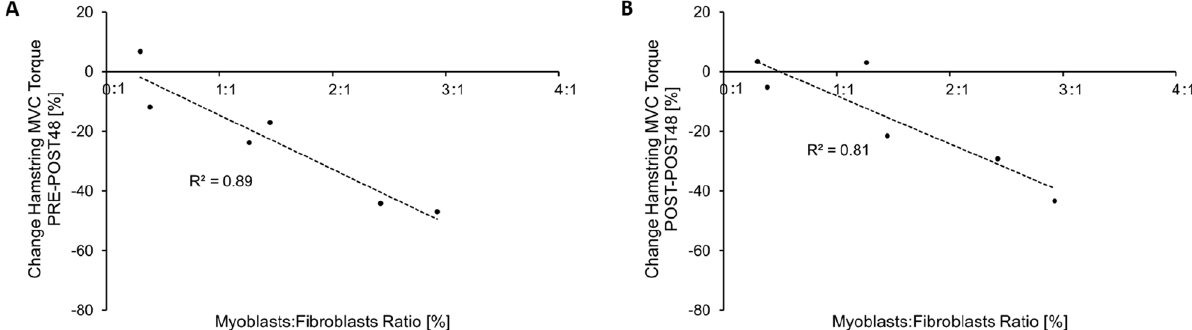
Figure 5. Inverse correlation between the myoblast:fibroblast ratio, assessed in the current in vitro study and the change of hamstring MVC torque measured ( A ) before and 48 h after (P = 0.004), and ( B ) measured immediately after and 48 h after (P = 0.014) ( B ) the repeated maximal sprint intervention. This figure was produced in Microsoft Excel unteered to provide a muscle biopsy at least three weeks before completing the repeated maximal sprint inter- vention). As muscle fibre-type composition is similar between the quadriceps and hamstrings 32 , the stem cell composition of the vastus lateralis was considered representative of both the quadriceps and hamstring muscle groups. The mean ± SD myoblast:fibroblast ratio of the six participants was 1.46 ± 1.06 (range 0.299–2.93). There was an inverse correlation between myoblast:fibroblast ratio and the percentage change in relative hamstring MVC torque measured PRE-to-POST48 in vivo (R 2 = -0.89, F 1,4 = 33.73, P = 0.004; Fig. 5). Thus, participants with a high myoblast:fibroblast ratio showed a delayed hamstring strength recovery 48 h after repeated maxi- mal sprints compared to those with a low myoblast:fibroblast ratio. Further, there was an inverse correlation between myoblast:fibroblast ratio and relative hamstring MVC torque measured POST-to-POST48 (R 2 = − 0.81, F 1,4 = 17.08, P = 0.014; Fig. 5). No correlations were found between the myoblast:fibroblast ratio and changes in quadriceps MVC torque or with any other muscle damage and fatigue biomarker following repeated maximal sprints. These inverse correlations could be confounded by the model assumptions and the relative low par- ticipant number. However, post hoc power calculations demonstrate that the bivariate correlation had adequate power (0.97).